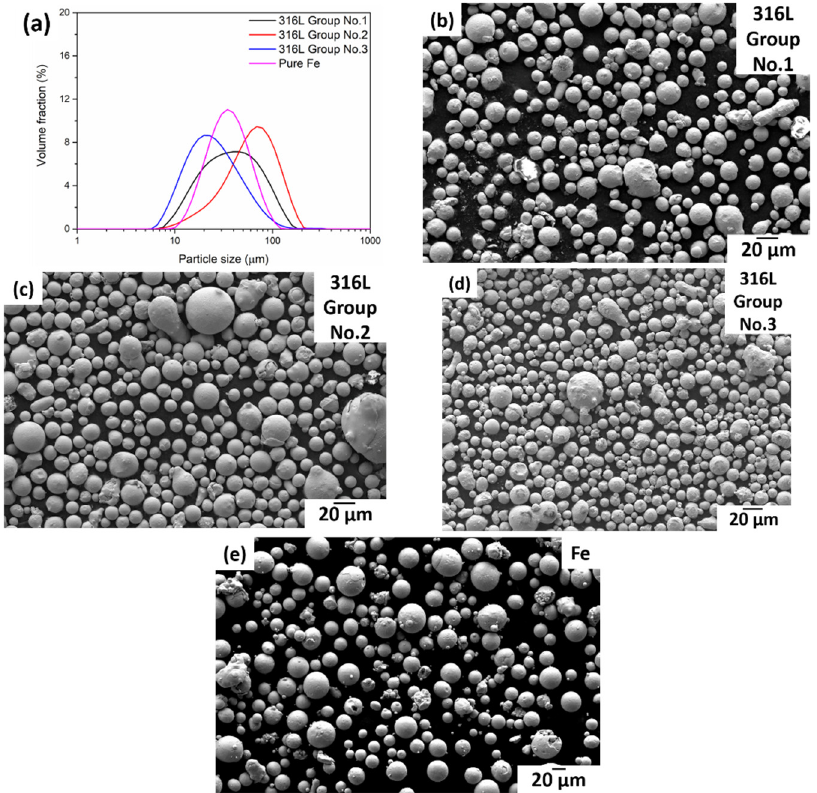
Figure 1. ( a ) Powder particle size distribution for CCA, cold gas 20 °C (group No. 1), FFA, hot gas 220 °C (group No. 2) and CCA hot gas 470 °C (group No. 3) and SEM micrographs of the atomised 316L powder of ( b ) CCA, cold gas 20 °C (group No. 1), ( c ) FFA, hot gas 370 °C (group No. 2), ( d ) CCA hot gas 370 °C (group No. 3) and ( e ) industrially produced pure Fe powder. Table 3. Particle size distribution of the 316L steel powder produced by three argon gas atomisation routes and industrially produced pure Fe powder.